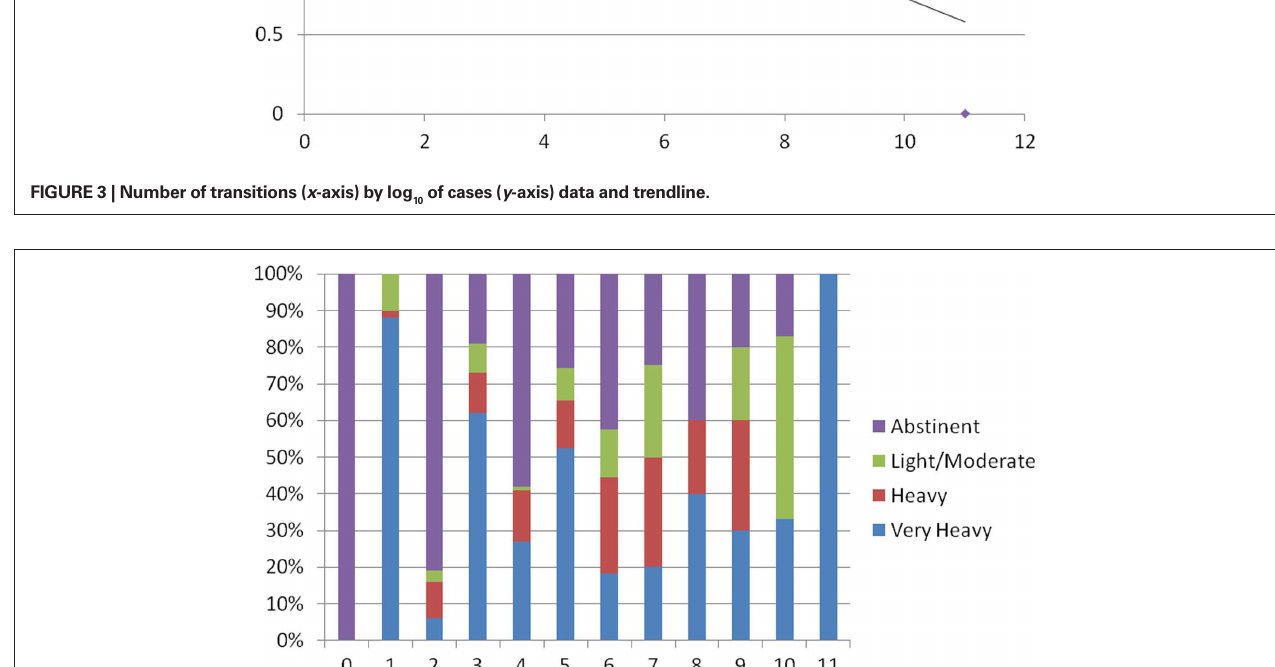
Figure 4 | endpoint by number of transitions ( x